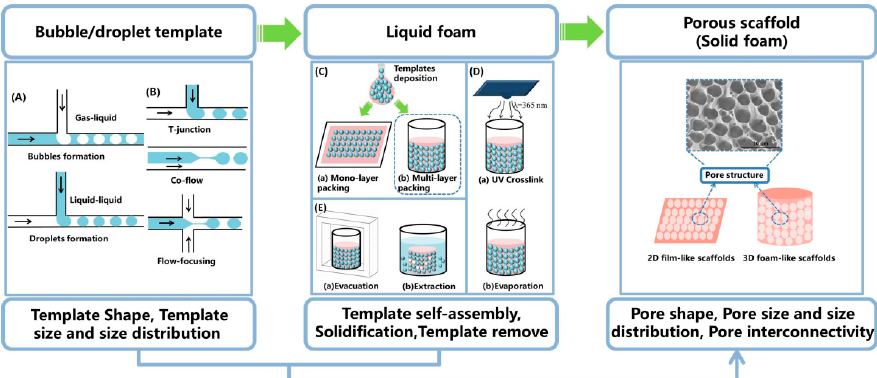
Figure 3. Schematic diagram: making porous scaffold with controlled structures via microfluidic technology. ( A ) Generation of templates, including bubbles formation and droplet formation; ( B ) Three common microfluidic channel geometries, including T-junction, co-flow and flow-focusing; ( C ) Self-assembly of templates, including mono-layer packing and multi-layer packing; ( D ) Solidification of external phase, including UV crosslink and evaporation; ( E ) Remove of templates, including evacuation and extraction.